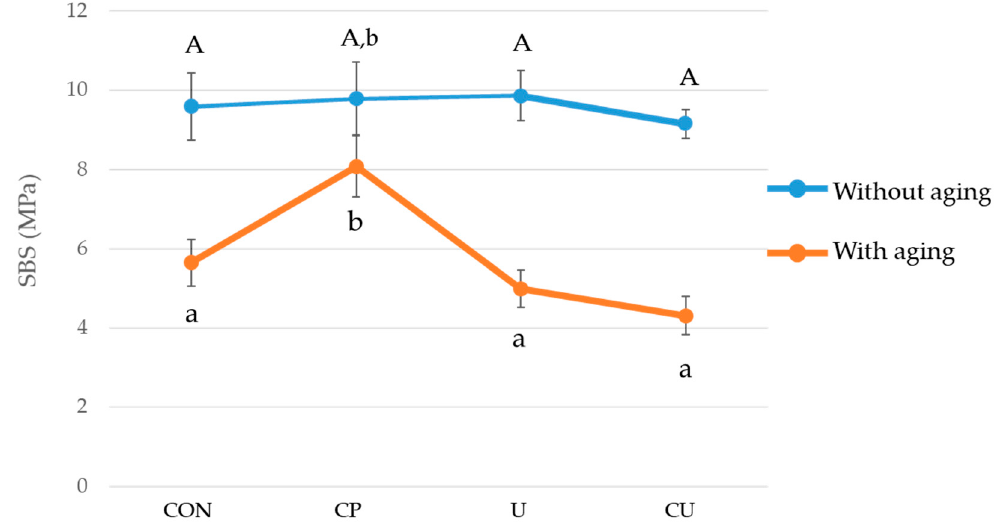
Figure 4. Shear bond strength values obtained when orthodontic ceramic bracket was bonded to enamel (CON0, CON1) or Y-TZP (CP0, CP1, U0, U1, CU0, CU1), with or without thermocycling (aging). The vertical bars indicate the standard deviations. There are significant differences in SBS between the groups marked with different letters A, a and b ( p < 0.05).